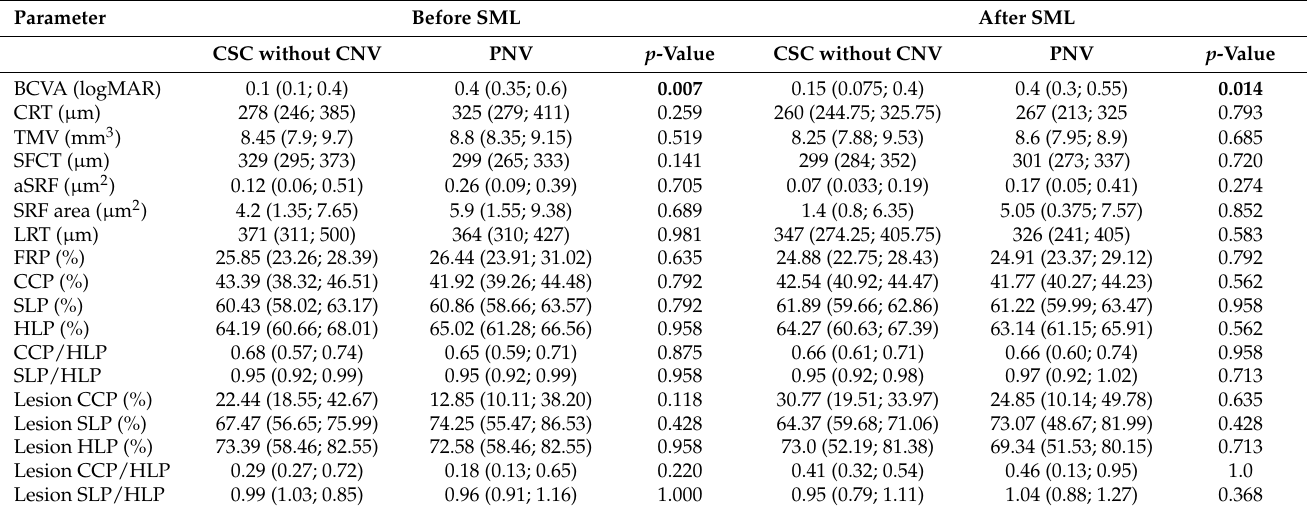
Table 6. Comparison of anatomical and functional parameters of the two subgroups before and four weeks after